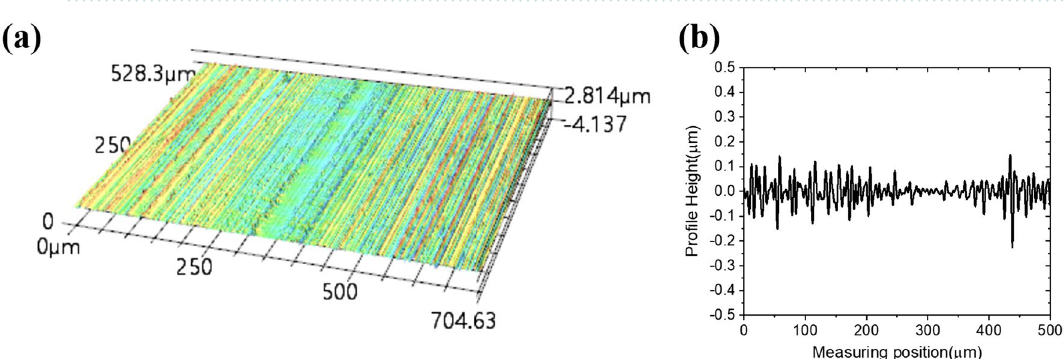
Figure 10. The planing process for removing the conductive carbon ink applied over the PMMA workpiece and the machined workpiece after removing the over filled ink.